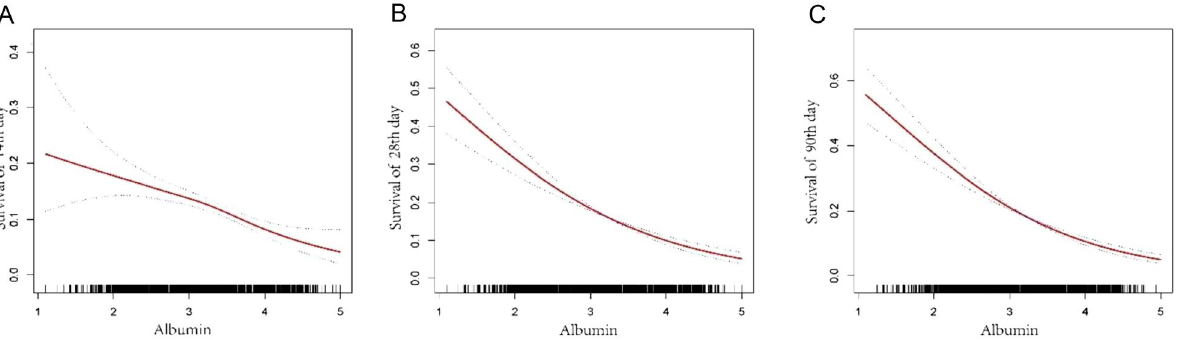
Figure 3. Restricted cubic spline curve showing the adjusted hazard ratios for all-cause mortality as a function of average albumin concentration. Albumin as a continuous variable, model adjusted for heart rate; SBP; mean arterial pressure; diastolic pressure; respire rate; temperature; SPO2; platelet; potassium; sodium; creatinine; hemoglobin; WBC; AST, BNP, LVEF, diuretic, ACEI/ARB/ARNI, cardiac glycoside. At the figure, the frequency distribution of albumin is